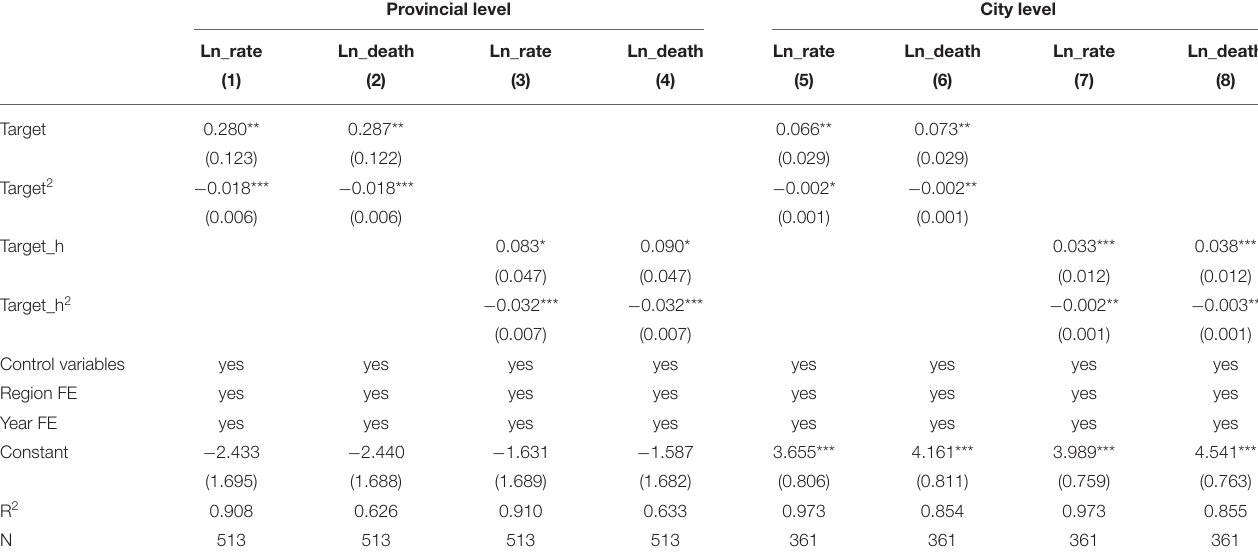
TABLE 7 | Robustness cheque: control the effect of differences at the administrative